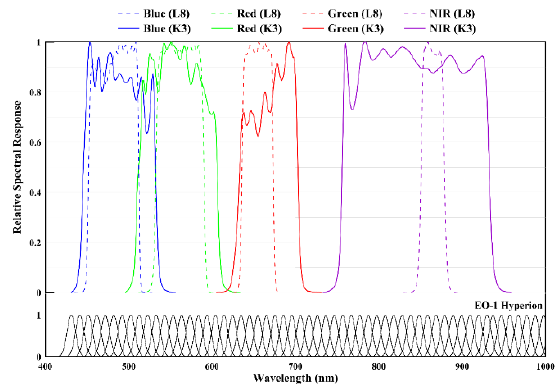
Figure 1. RSR of the sensor used in this study